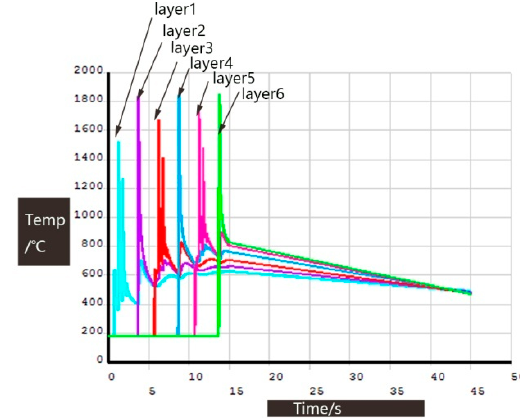
Figure 9. Simulation of temperature of the middle points of layers 1–6.